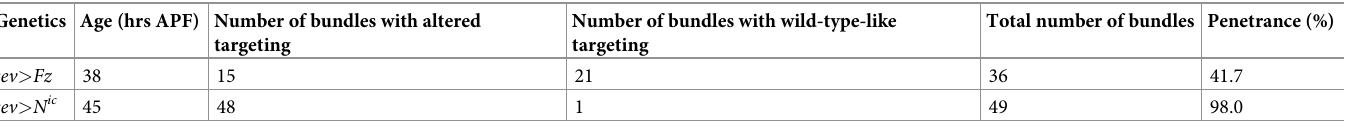
Images of sev > Fz specimens at 38 hrs APF and sev > N ic specimens at 45 hrs APF were visually inspected and counted. Only bundles with two R3s (bundles with two RFP-positive R cell growth cones and no GFP-positive R cell growth cones) or bundles with two R4s (bundles with two GFP-positive R cell growth cones) are included in the counting. n = 13 biological replicates for sev > Fz flies and n = 5 biological replicates for sev > N ic flies. We note that the targeting penetrance we observe is on par with that of previous studies in both this system [10,11] and others